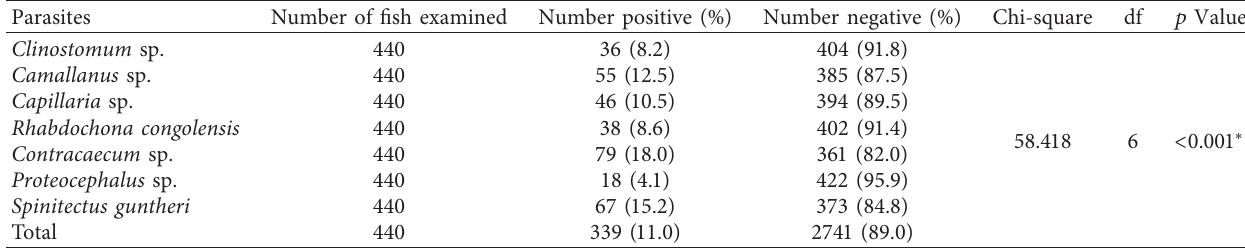
Table 2: Parasites in fish species in rivers Niger and Benue at Lokoja. Parasites Number of fish